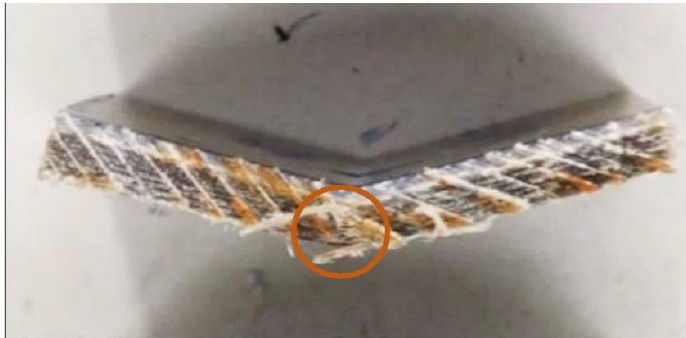
Figure 17. Embroidery 8 mm sample with crack flexure, and tension (own source).